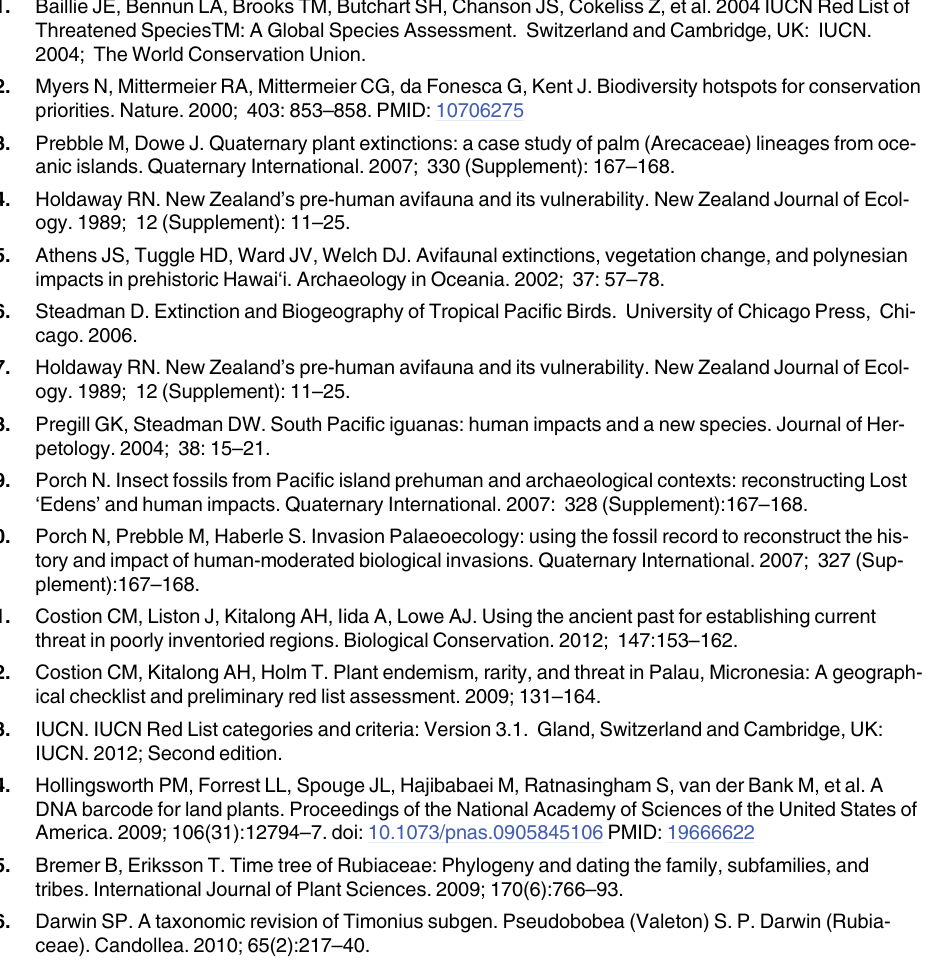
S3 Table. DNA sequence list. List of GenBank accession numbers for all nucleotide sequences generated and used in the